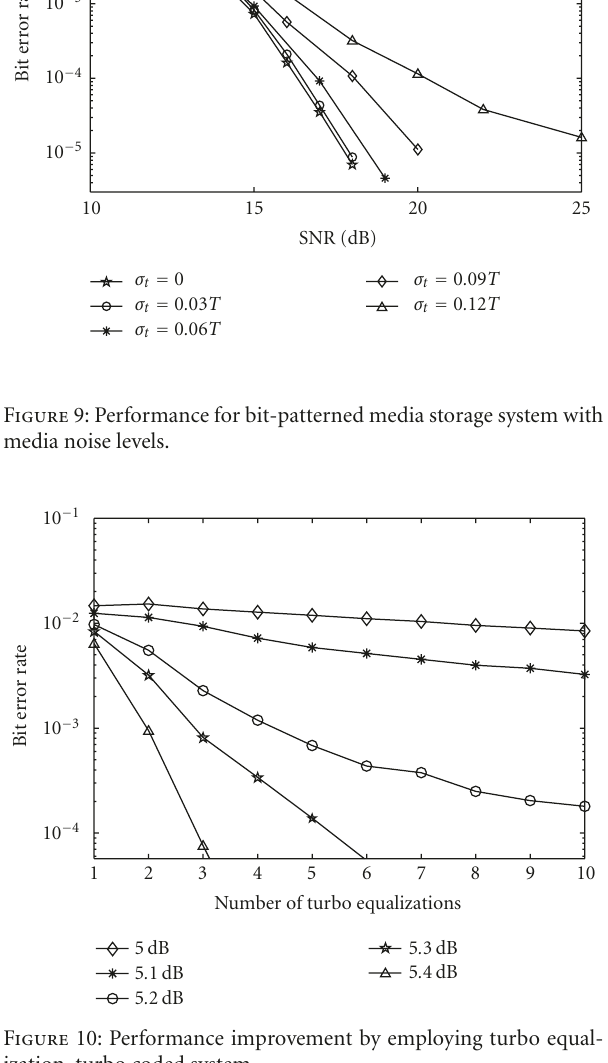
Figure 8: Performance for conventional media storage system with media noise levels.